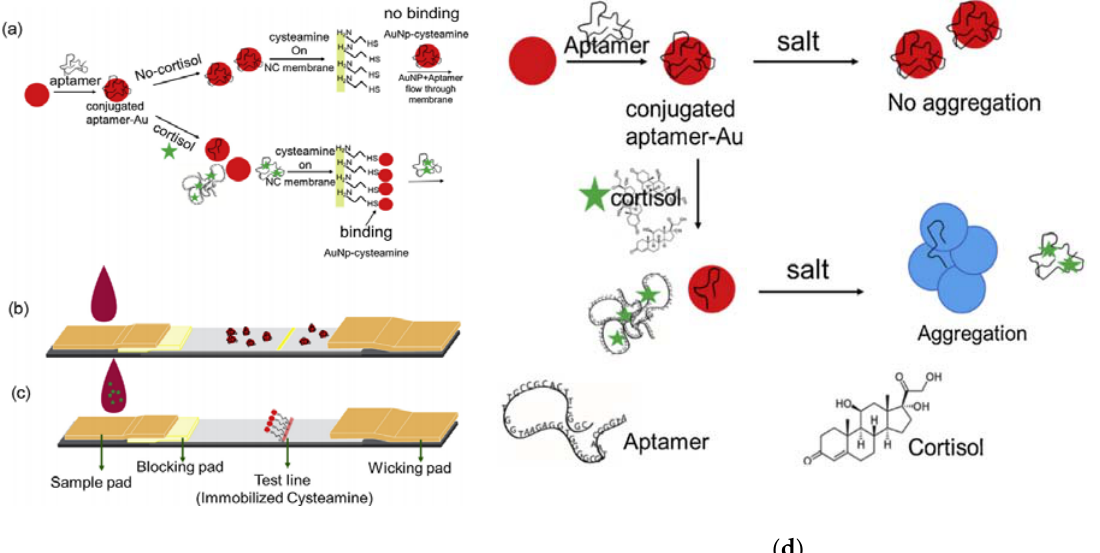
Figure 3. ( a ) Cortisol detection utilizing AuNP-aptamers: ( b ) negative control, for which there is no change in color in the absence of cortisol; ( c ) color change when cortisol is present; ( d ) process of cortisol effectiveness in releasing aptamers following salt aggregation. Reproduced from Dalirirad and Steckl [43].